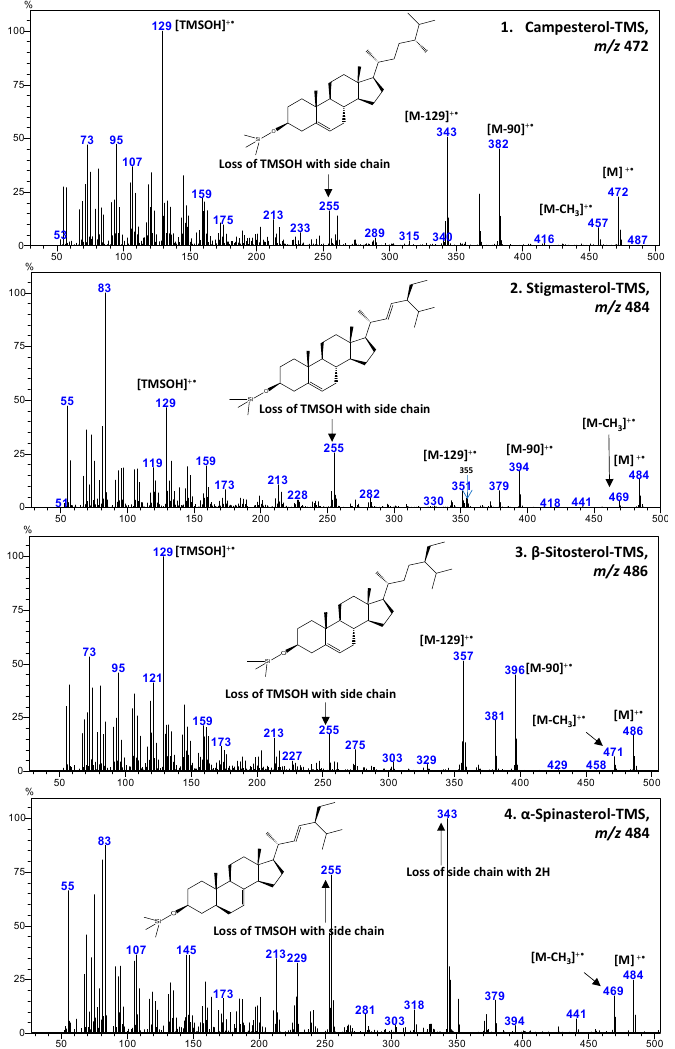
Figure 3. The gas chromatography (GC)-mass spectra of most abundant sterols identified in the present study from the seed spices of the Apiaceae family. The mass spectra of campesterol, stigmasterol, and β‐ sitosterol are from celery, while α‐ spinasterol is from Ajwain. In the mass spectrometric identification of sterols, an ion at m/z [M ‐ 90] +• , for the loss of trimethylsilanol (TMSOH), and loss of the TMSOH with side chain is a common feature